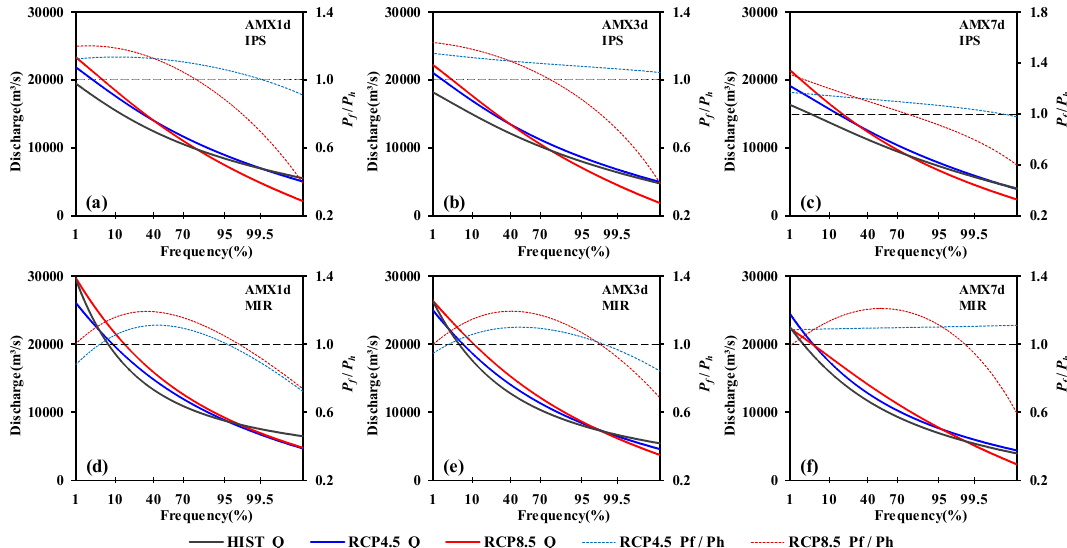
Figure 8. Generalized extreme value (GEV) frequency distributions of AMX n d in Pingshan under different climate change scenarios. HIST_Q, RCP4.5_Q and RCP8.5_Q means the value of AMX n d. RCP4.5_ P f / P h and RCP8.5_ P f / P h means the ratio between projected value ( P f ) and historical value ( P h ).